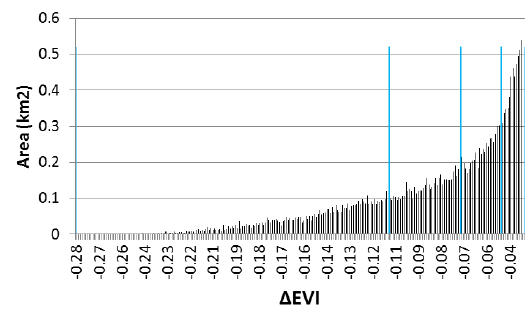
Figure 4: Areal distribution of anomalies of the Enhanced Vegetation Index for the May 27, 2011 tornado in the Great Smoky Mountains National Park. Blue vertical lines divide the affected area into four equal-area groups.